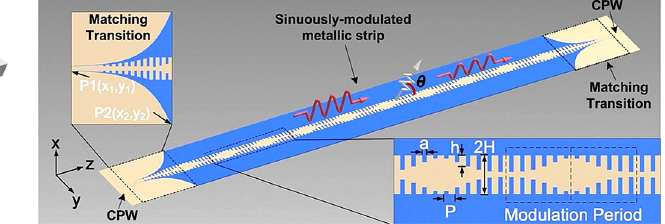
Fig. 2. The schematic of a sinusoidally modulated SSPP leaky- wave antenna proposed